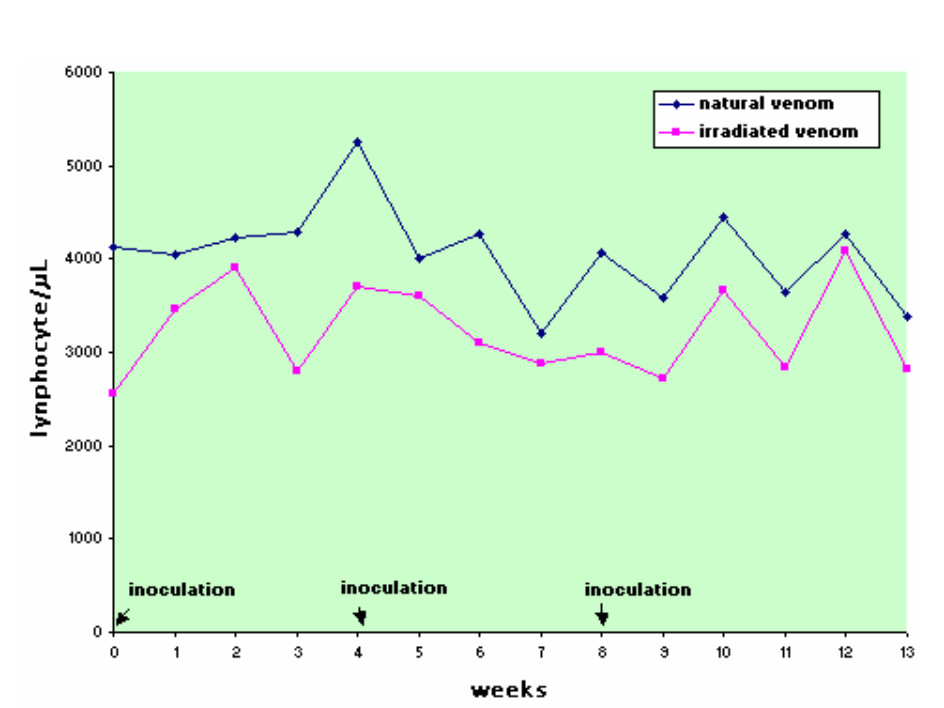
Figure 4 . Mean values of lymphocyte (cells/ µ L) count in sheep (n=12) inoculated with natural (NV) Cobalt -irradiated (IrV) crotalic venom. 60